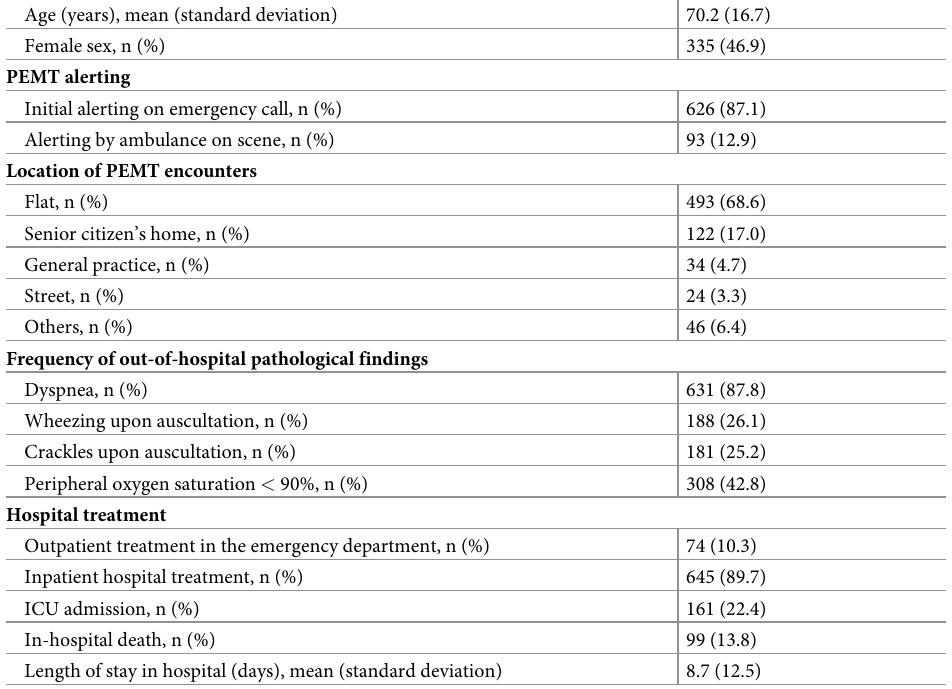
Table 1. Characterization of patients, PEMT encounters, and hospital follow-up. Age (years), mean (standard